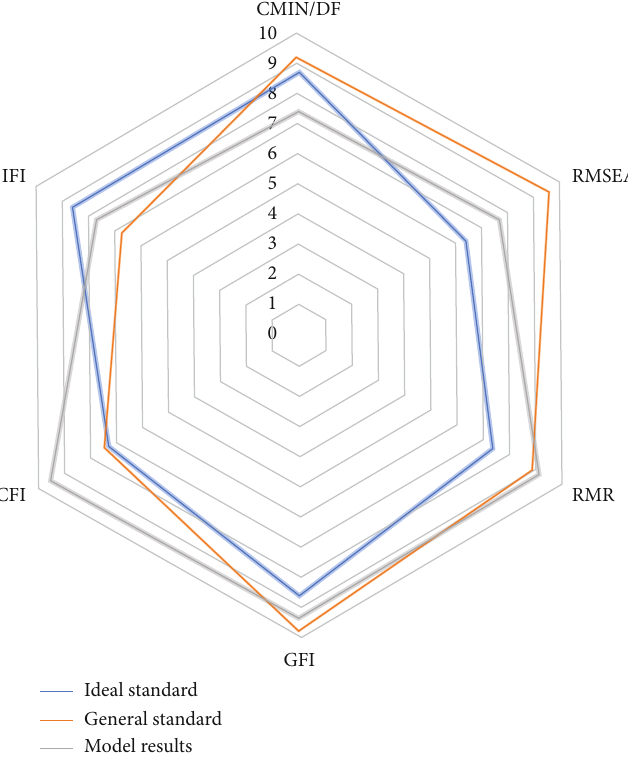
Figure 3: Analysis of the overall goodness-of- fi t of the model. Table 3: Intermediary model with